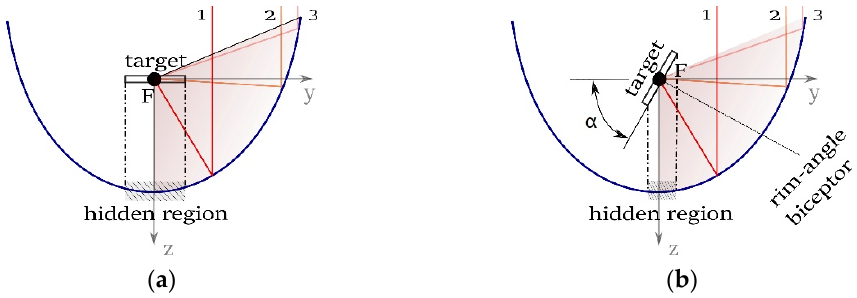
Figure 5. Position of the target on the focal line. ( a ) Parallel to the aperture and ( b ) tilted at an angle α .